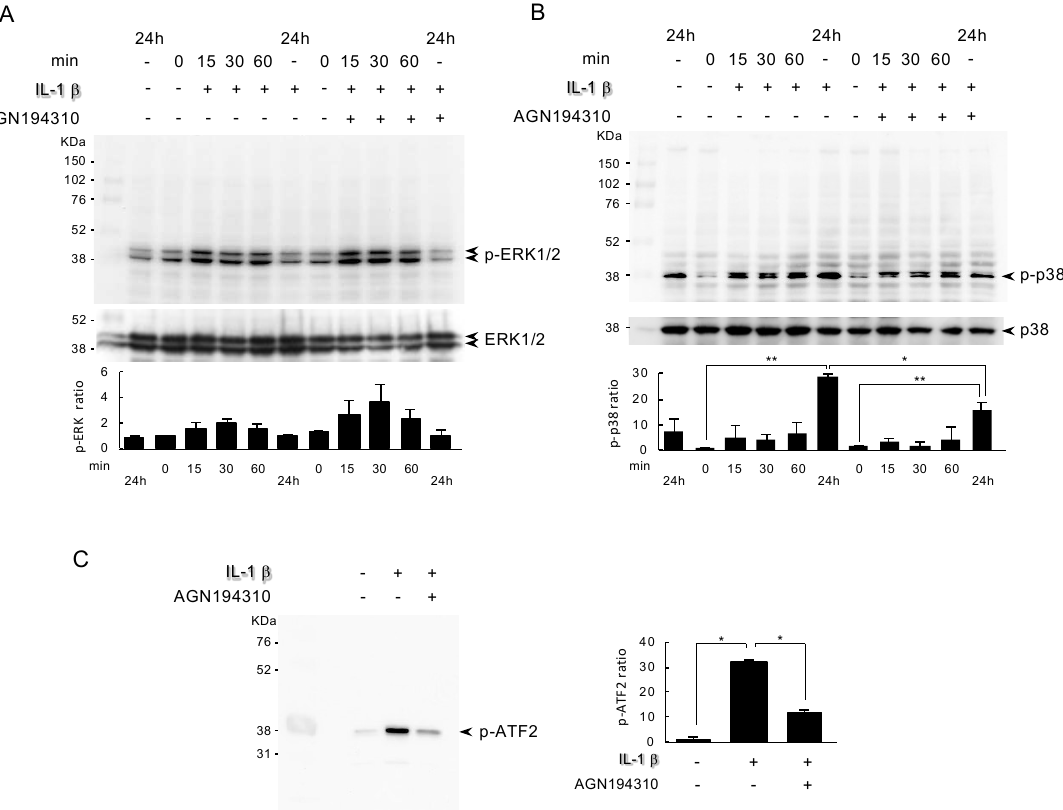
Figure 4. Analysis of the actions of the RAR inverse agonist AGN194310 on IL-1 β -induced mitogen-activated protein kinase (MAPK). ATDC5 cells were exposed to 10 ng / mL IL-1 β with / without 100 nM RAR inverse agonist AGN194310 for the indicated times, and the cell lysates were processed for an immunoblot determination of phosphorylated extracellular signal regulated-kinase (pERK1 / 2) ( A ) and p-p38 MAPK ( B ). ( C ) The level of activated p38 MAPK activity was determined by a kinase activity assay. Results shown are representative of three independent experiments, and further quantification by densitometry of triplicates. Densitometric analysis of pERK1 / 2 normalized to total ERK1 / 2 and p-p38 normalized to total p38, represented as times control. Bars show mean ± SD. Statistically significant di ff erences (* p < 0.05, ** p < 0.01) between the indicated groups are marked by